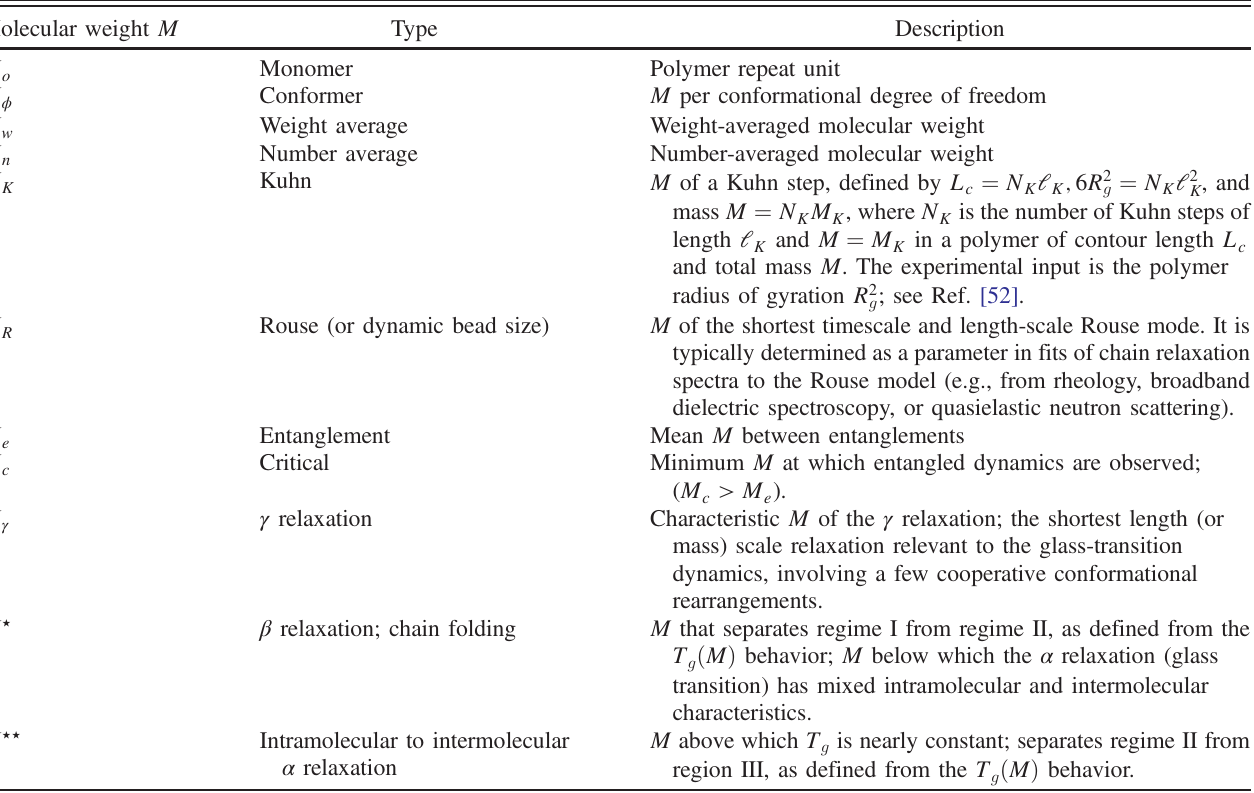
TABLE I. Characteristic molecular weights. Molecular weight